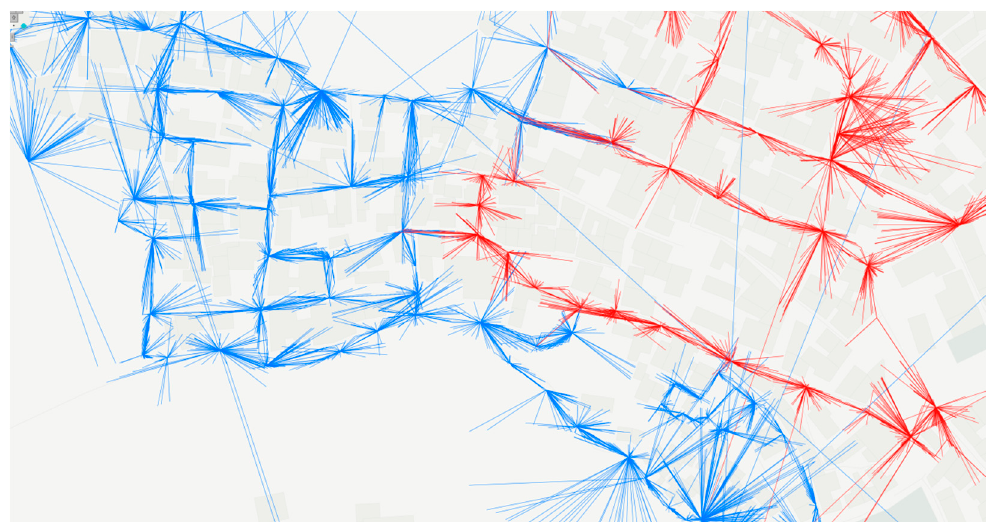
Figure 18. Network of observed features scaled.